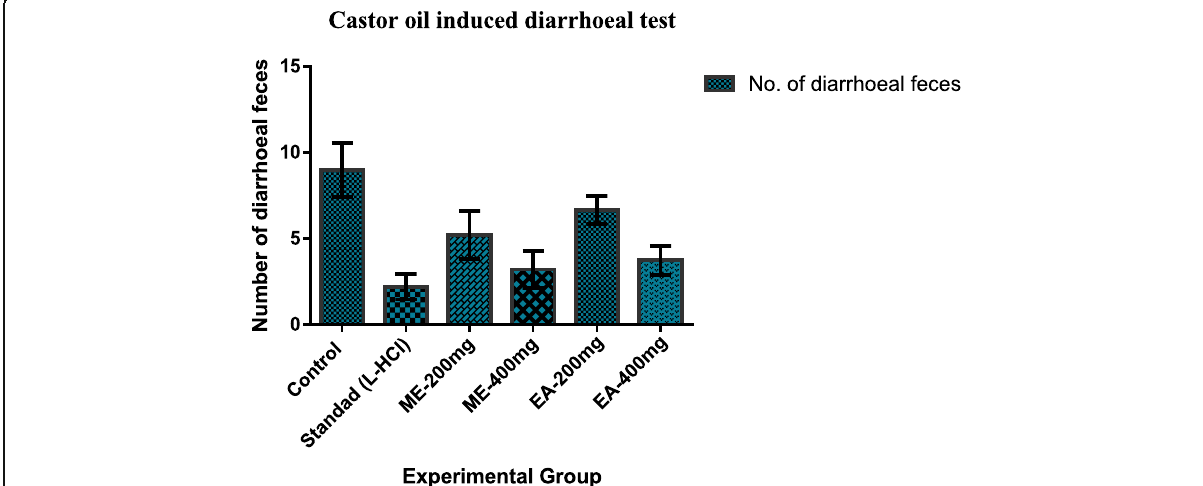
Fig. 5 Effect of Hemigraphis alternata methanolic and ethyl acetate extract treatment on castor oil induced diarrhea in mice. Each bar represents the mean ± standard error of the mean of diarrhoeal feces of five